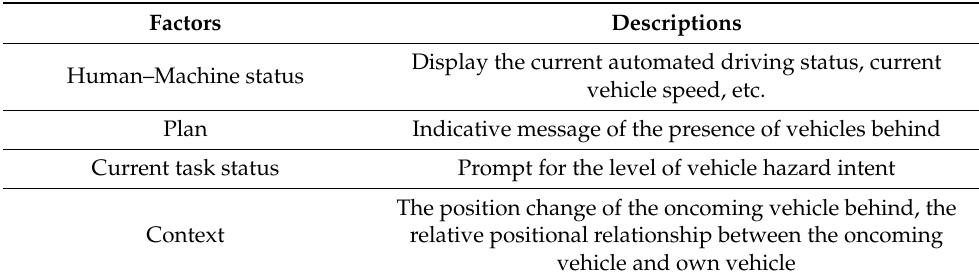
Table 3. Descriptions of Levels of